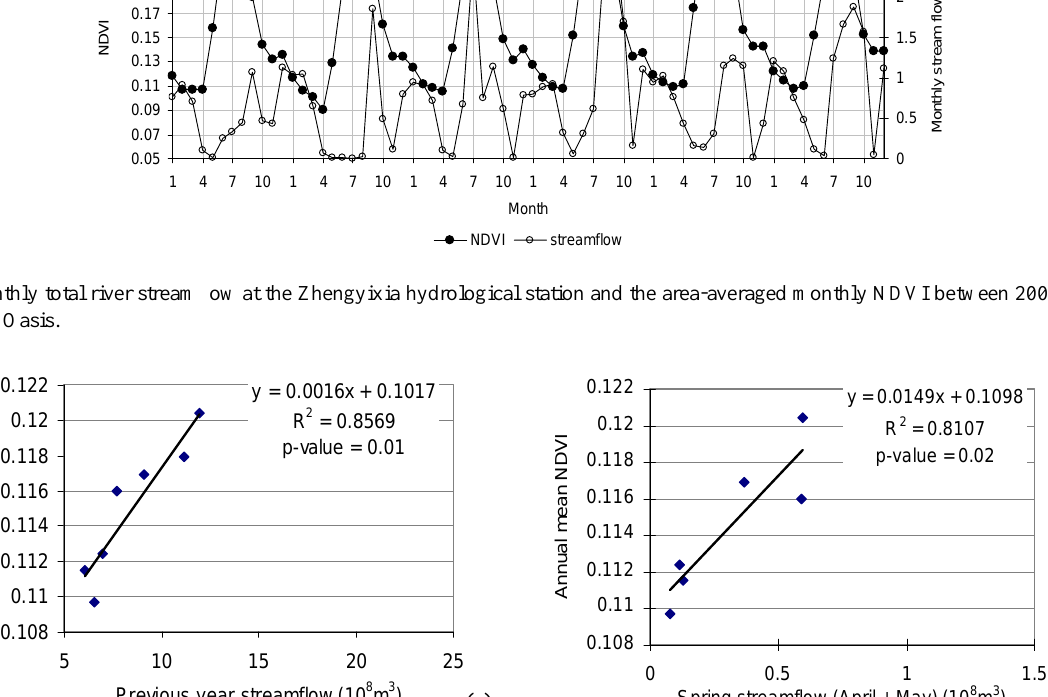
Fig. 9. (a) Area-averaged annual mean NDVI of year N versus total river streamflow of year (N-1); (b) Area-averaged annual mean NDVI of year N versus total river streamflow of March through May of year N.